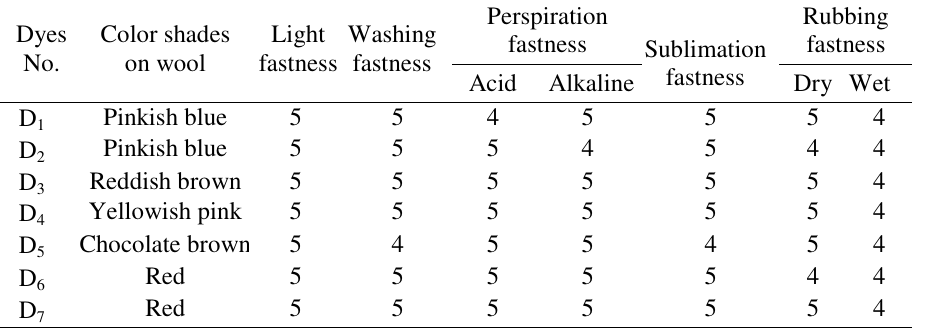
Table 4. Results of mordent acid azo dyeing and various fastness properties of dyes on wool.